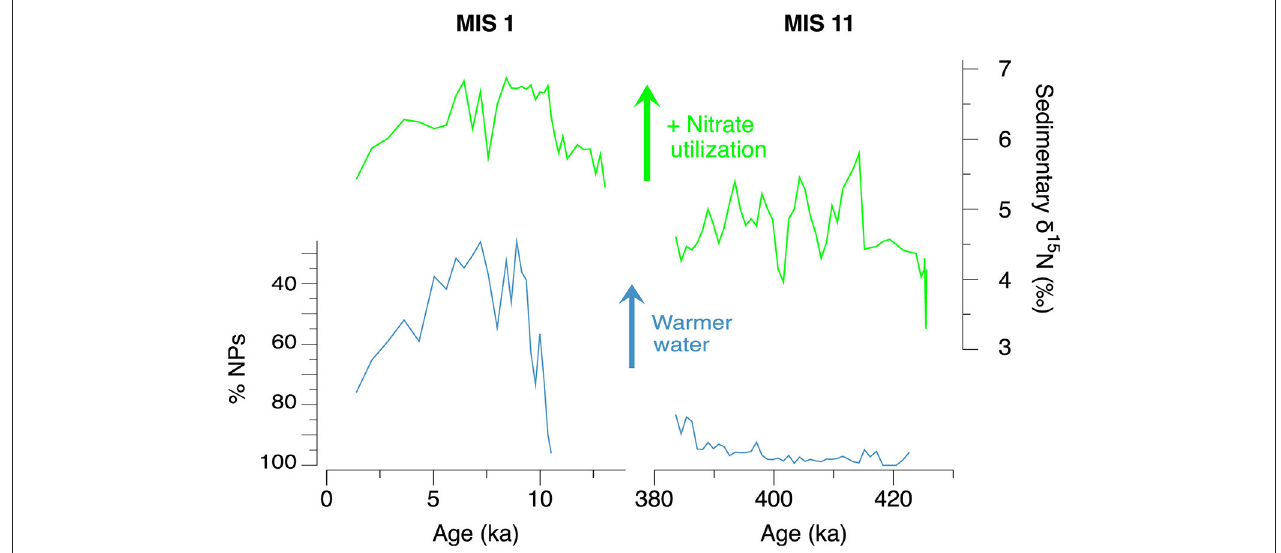
FIGURE 1 | MIS 11 vs. MIS 1 in the Nordic Seas. (Top to bottom) Stable oxygen isotope signature of NPs for MIS 11 (right) and MIS 1 (left) with errors reported as ± 0.08 ‰ . Stable nitrogen signature of host-sediment nitrate for MIS 11 (right) and MIS 1 (left) with errors reported as ± 0.2 ‰ . % NPs as a temperature proxy in MIS 11 (right) and MIS 1 (left) . All data were taken from (Thibodeau et al., 2017a).